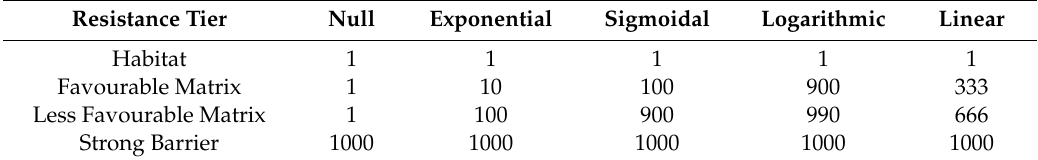
Table 3. Resistance values from each transformation for each landscape resistance tier. Movement habitat and strong barriers were valued at 1 and 1000, respectively. The dotted lines indicate the locations of high contrast transitions between resistance